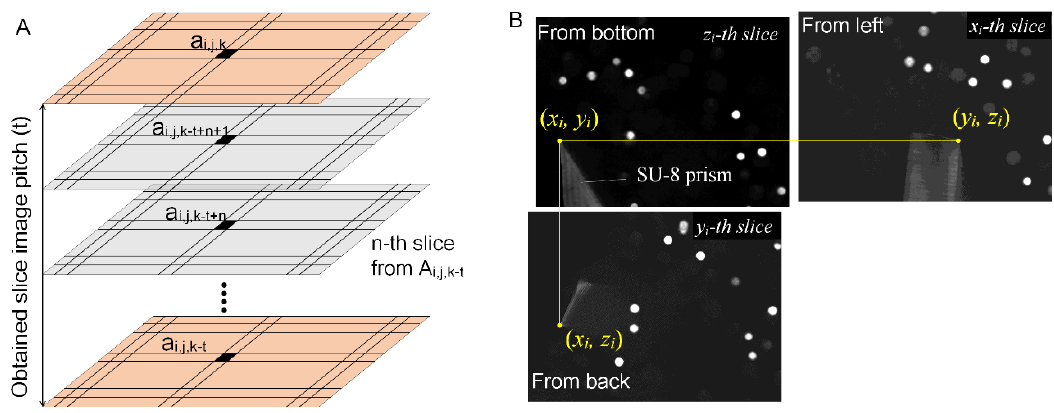
Figure A1: Image processing for synchronizing multiple datasets.